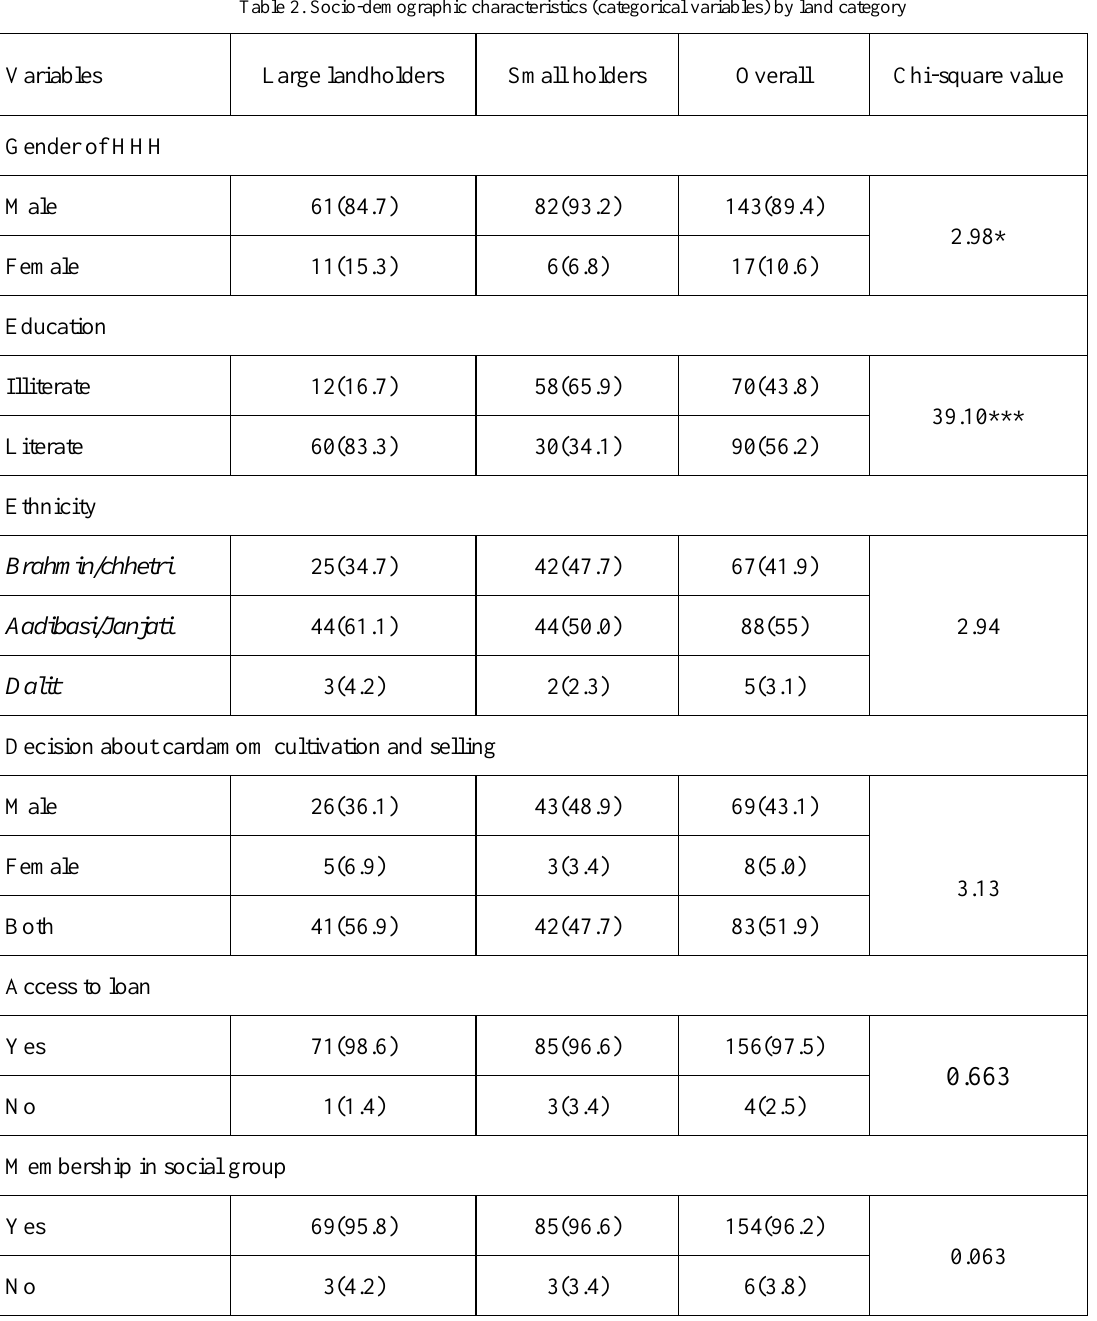
Table 2. Socio-demographic characteristics (categorical variables) by land